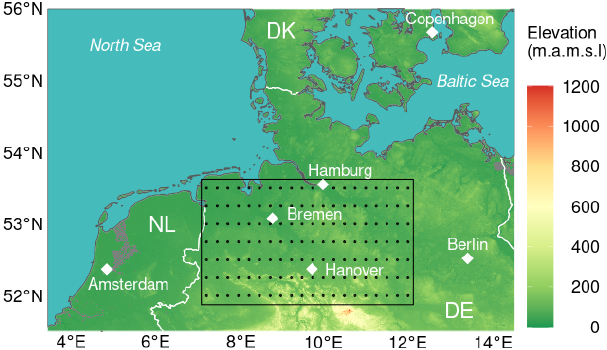
Figure 1. Study region in northern Germany (black rectangle). Co- ordinates: 52.00 ◦ N, 7.25 ◦ E (southwestern corner) and 53.50 ◦ N, 12.00 ◦ E (northeastern corner). Area: 53295km 2 . Dots show the centers of the ERA5 0.25 ◦ latitude–longitude grid. Elevation is mostly below 100ma.m.s.l. Data: TanDEM-X (Rizzoli et al., 2017; Wessel et al., 2018). DE: Germany, DK: Denmark, NL: the Nether-